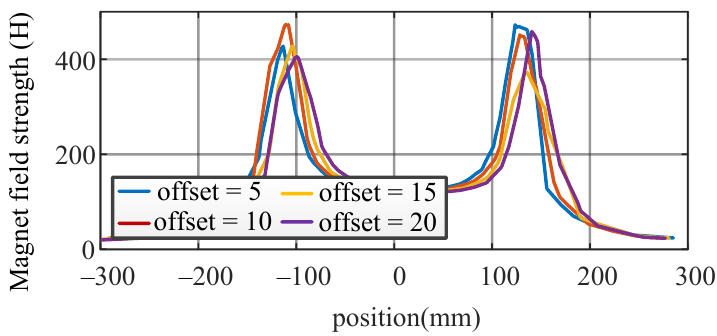
Figure 29. Magnetic field strength curves with the conventional structure and different offsets of the secondary coil .